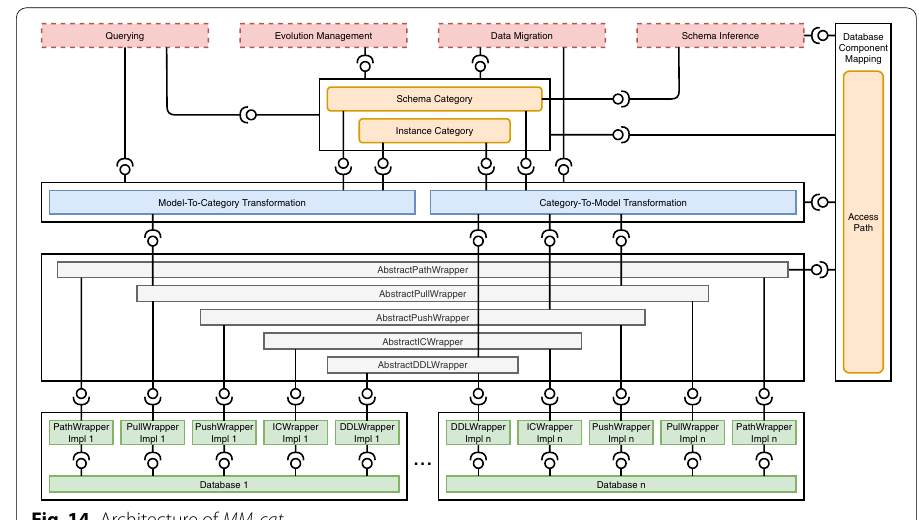
Fig. 14 Architecture of